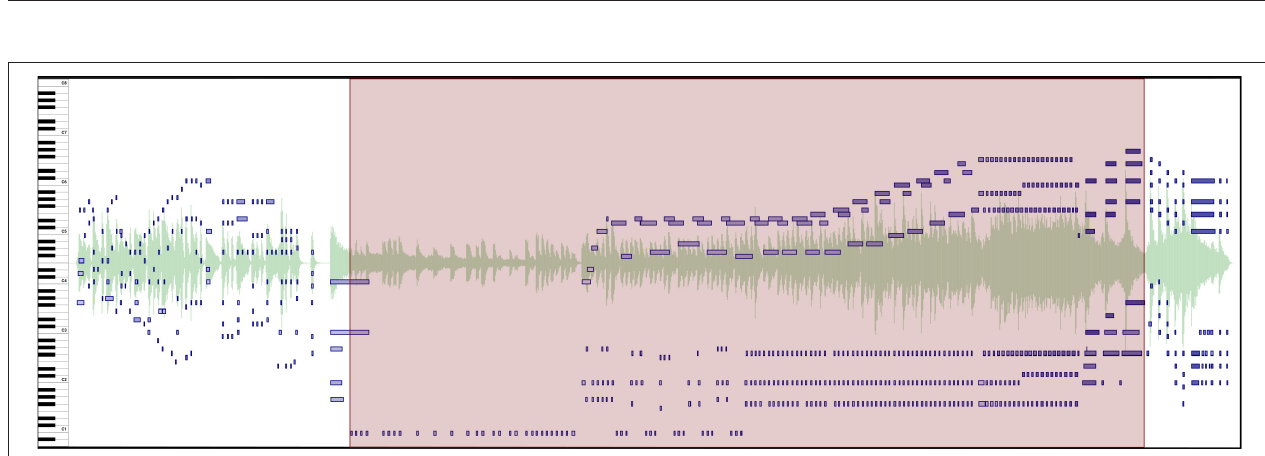
FIGURE 5 | Excerpt of a long transition marked with a region (light red rectangle) between Movements III and IV of Beethoven’s Symphony No. 5 in C minor. See Supplementary Video 3 in the Supplementary Materials to hear the music presented in this Figure.